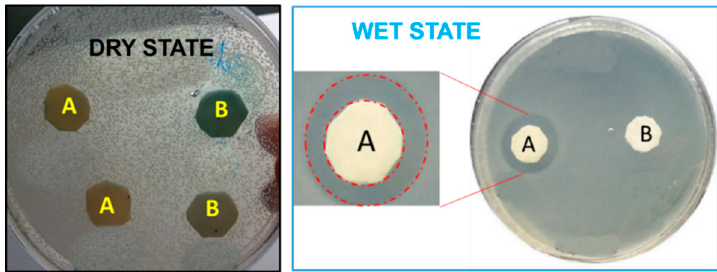
Figure 6. Modified Zone of Inhibition Test of P. aeruginosa after 24 h incubation with s-PBC@PP ( A ) and reference PP ( B ) coupons in dry state (on the left) and after adding 0.2 mL of water (on the right). The clear zone around the s-PBC@PP coupon is shown in detail (red dashed line).